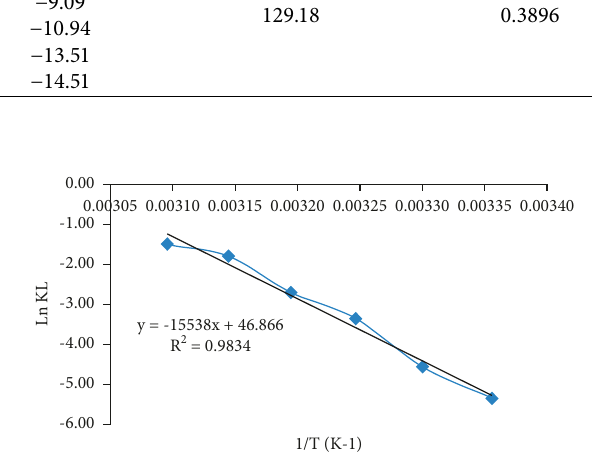
Figure 7: Van’t Hoff plot of RO16 onto U. prolifera -derived biochar.